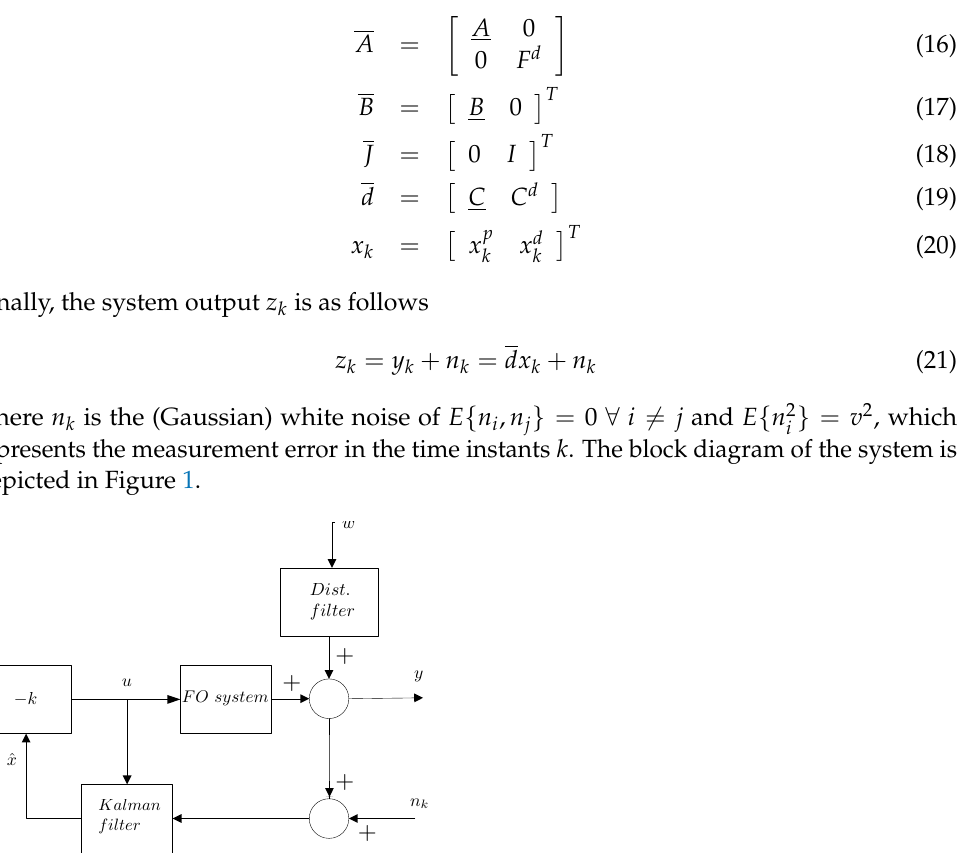
Figure 1. Block diagram of the controlled